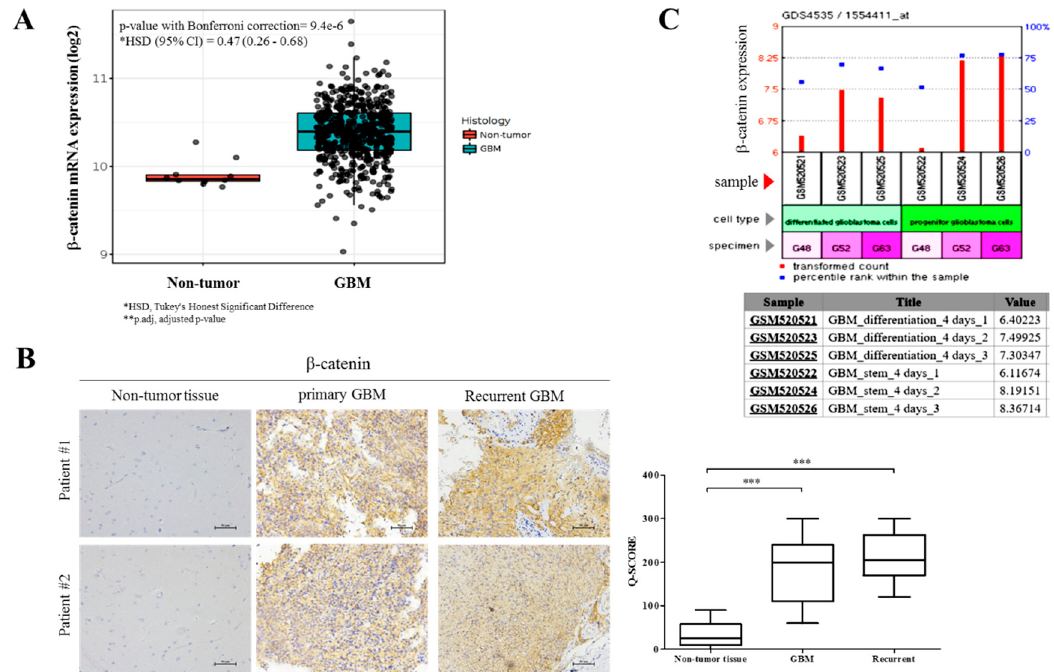
Figure 2. β -catenin facilitates GBM oncogenicity and disease recurrence, as well as their cancer stem cell-like traits. ( A ) TCGA brain dataset ( n = 557) using the Human Genome U133A Array showing the differential β -catenin mRNA expression in GBM ( n = 547) and normal brain ( n = 10) samples. ( B ) Immunohistochemistry (IHC) staining comparing expression of β -catenin in GBM, recurrent and adjacent non-tumor brain tissues in 2 Taipei Medical University Shuang Ho Hospital (TMU-SHH) brain tumor patients. * p < 0.05, ** p < 0.01, *** p < 0.001; GBM, glioblastoma. Scale bar: 50 μ m ( C ) GEO dataset GSE20736/GPL570/GDS4535 shows time-dependent enhancement of β -catenin expression levels in human progenitor GBM cells compared to their differentiated counterparts.